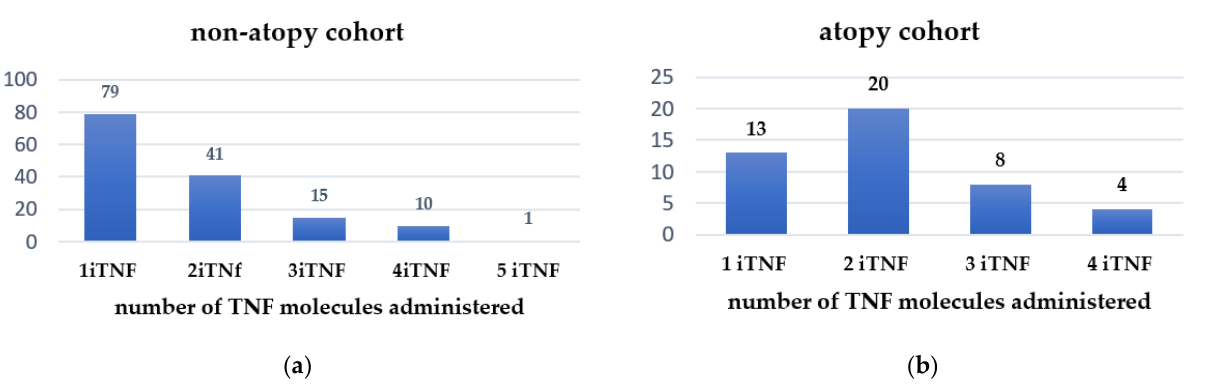
Figure 3. Number of TNF inhibitors used to treat SpAs patients: ( a ) non-atopic cohort; ( b ) atopic cohort.